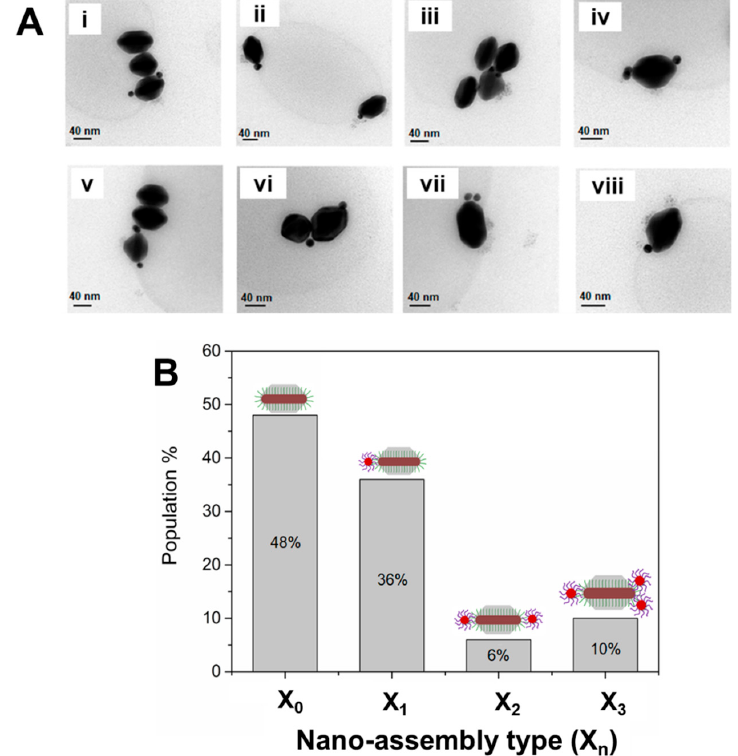
Figure 3. ( A ) (i–viii) Representative TEM micrographs of the anisotropic directional nanoassemblies obtained upon incubation of core AuNRs@T 18 -DNA@Ag (overgrown for 50 min) with satellite AuNPs@A 18 -DNA. ( B ) Nanoassembly yield (determined from statistical TEM analysis, population count = 100), resulting from the DNA hybridization of AuNRs@T 18 -DNA@Ag (overgrown for 50 min) with AuNPs@A 18 -DNA as a function of nanoassembly type X n , where n = number of spherical satellite NPs per assembly. Overall, the anisotropic directional nanoassembly yield was ~52% (X 1 , X 2 , X 3 ).